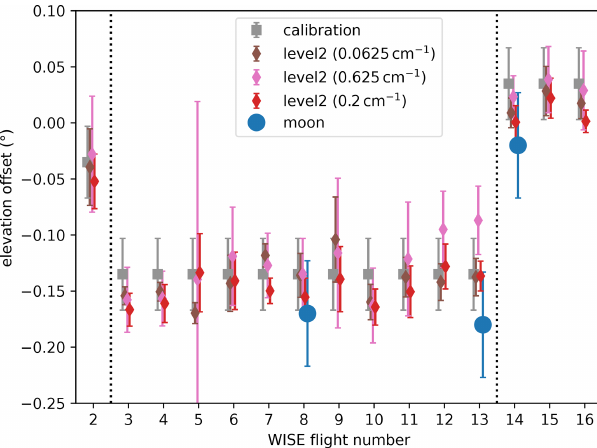
Figure 15. Values derived for the absolute elevation offset during the WISE campaign. Blue circles are offsets determined from moon measurements, while gray squares are values derived from cali- bration measurements taken pre- and post-campaign (pre-campaign for the first two flights, post-campaign for the remaining flights). Pink, red, and brown symbols are elevation angles determined from level 2 processing and ECMWF temperature data. The leftmost dot- ted line marks the point at which the inertial navigation system was changed, which invalidated the attitude calibration. The rightmost dotted line marks the point at which the employed elevation angle offset correction was changed, with the pointing corrected accord- ing to the best level 2 data at that